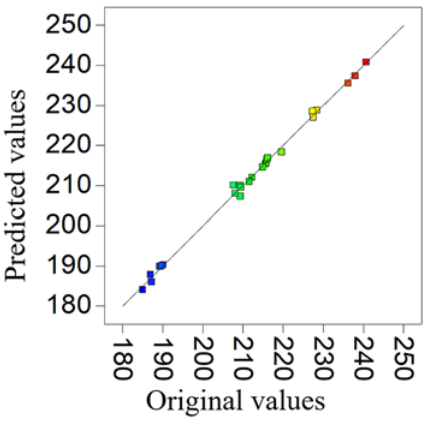
Fig. 18. Comparison of predicted and original calculated value.